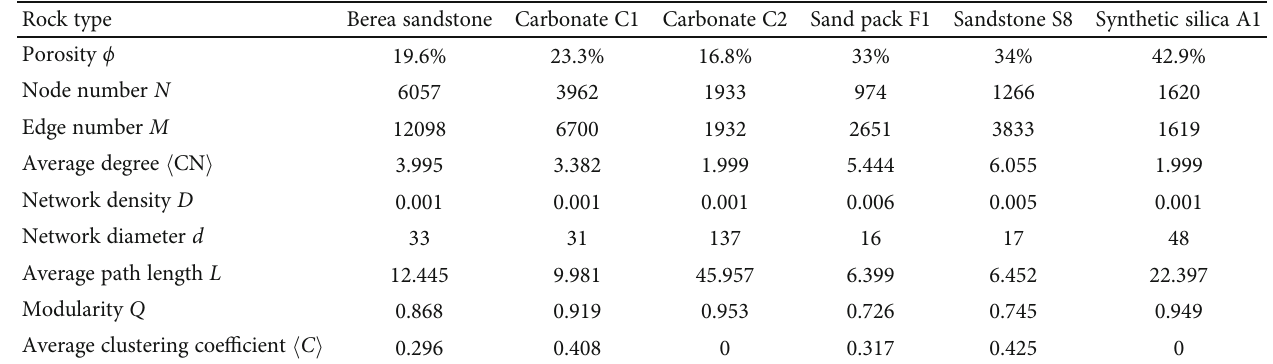
Table 1: Basic information of pore network.